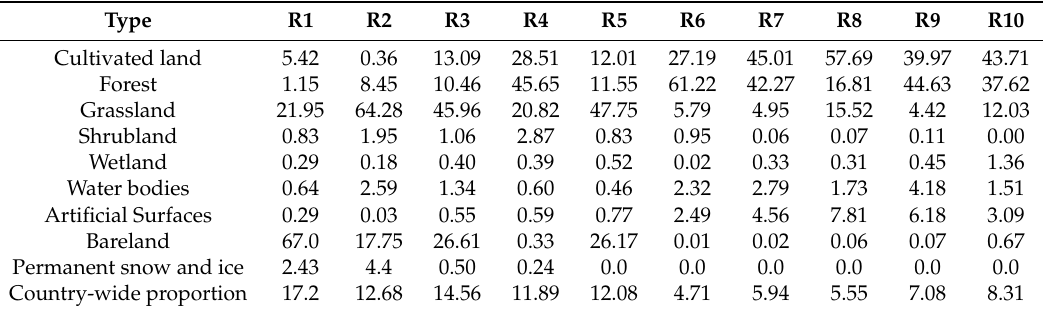
Table 2. The regional distributions of the mapped land-cover type (percent of area) for GlobeLand30 2010 over China. The sample size is 100 for all land-cover types in all regions with the exception that permanent snow and ice is not sampled in